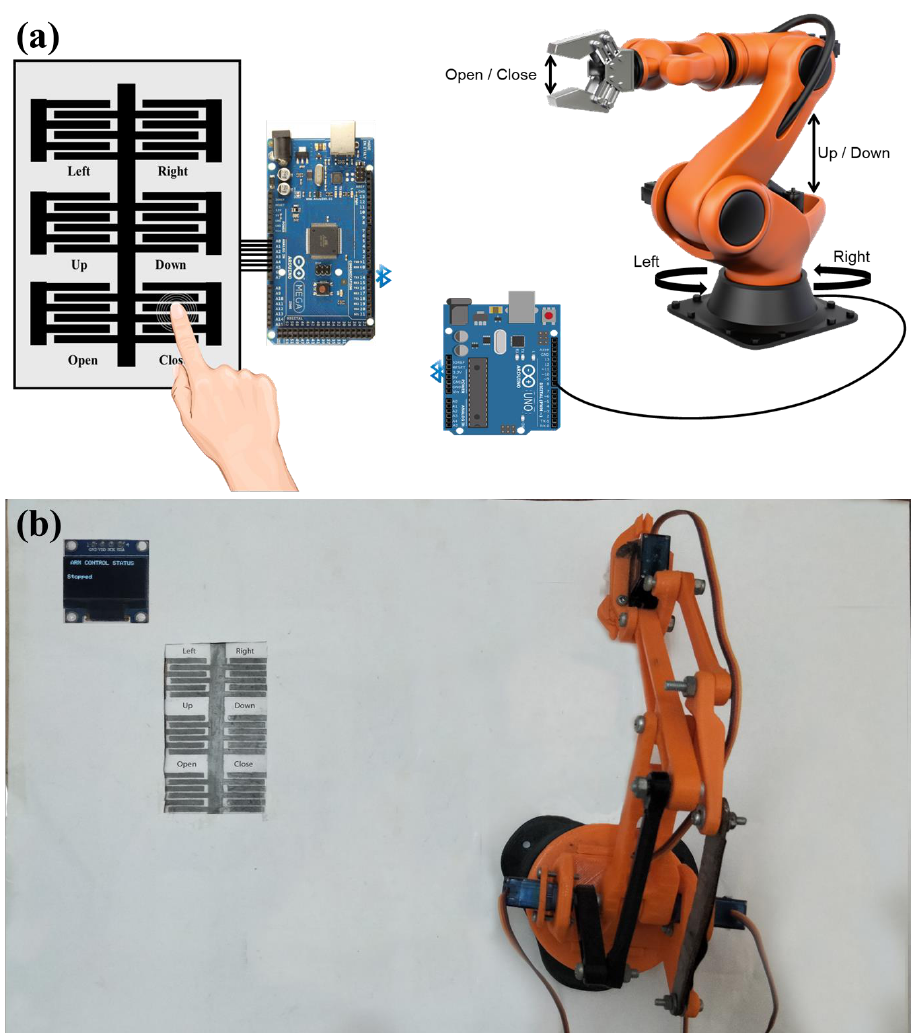
Figure 2. IDC touch keypad for an intelligent HMI. ( a ) Graphical illustration includes the keypad-based HMI integrated with an Arduino communicating through Bluetooth, with the Arduino attached to a robotic arm to control its movements. ( b ) Picture of the setup, including the graphite-on-paper-based IDC touch keypad and a robotic arm to be controlled with the HMI.